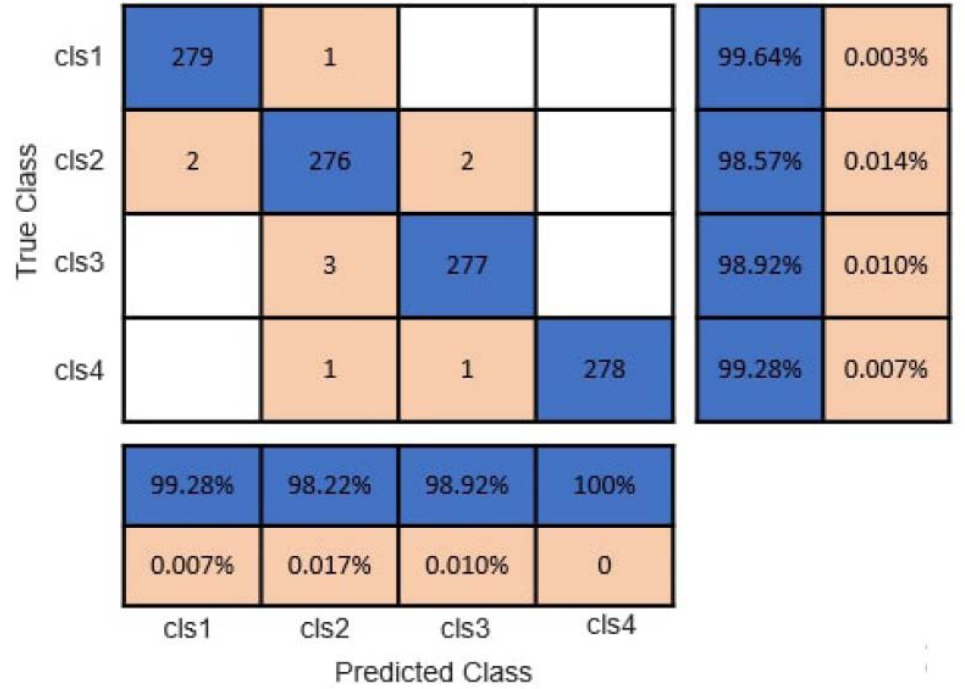
Figure 55. Bi-spectra results for the diagnosis of ( a ) outer race fault and ( b ) ball bearing fault [139].